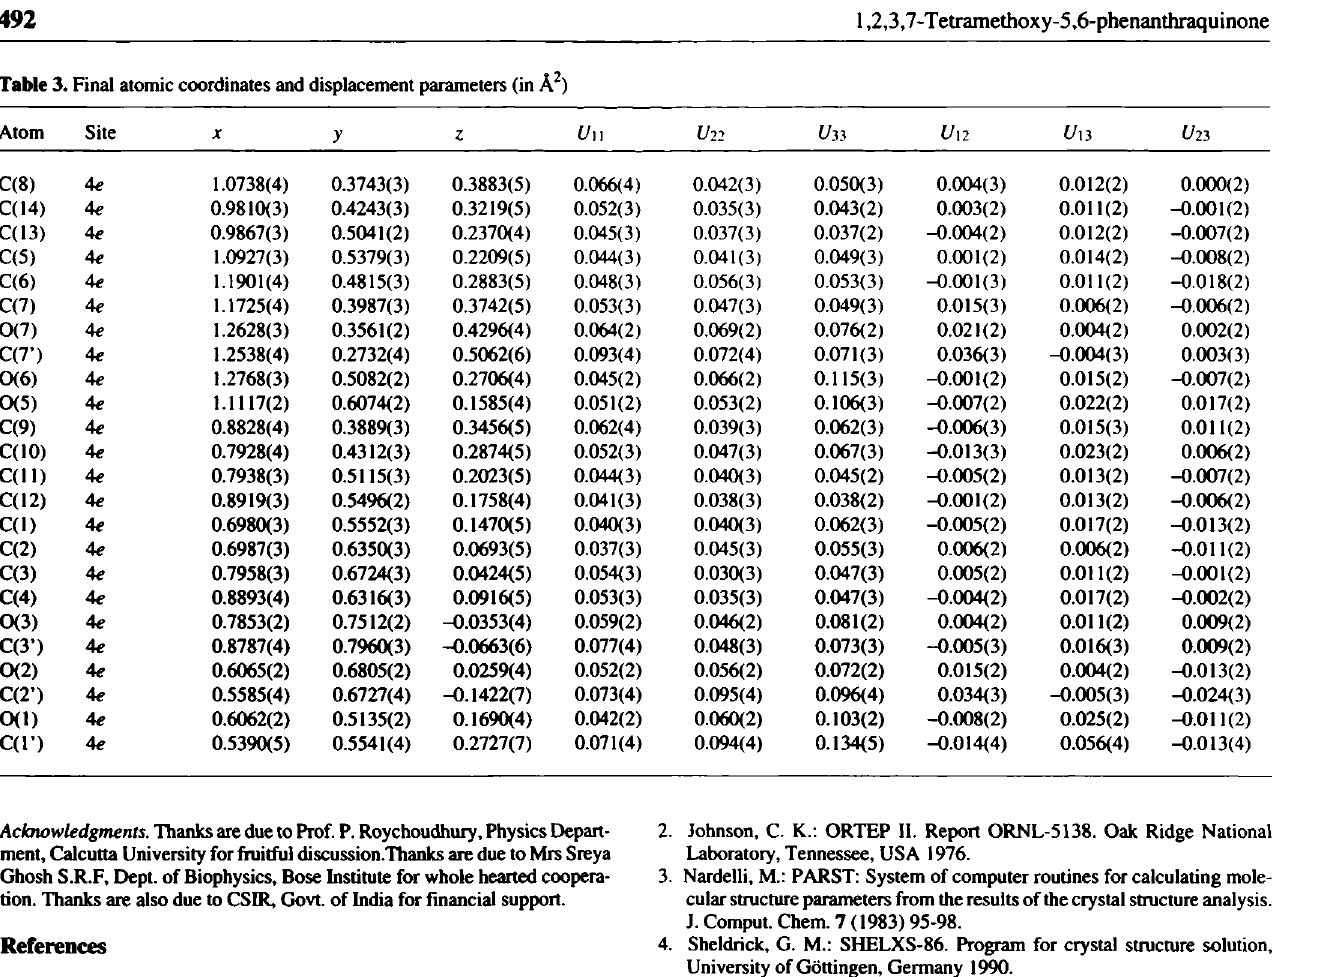
Table 3. Final atomic coordinates and displacement parameters (in